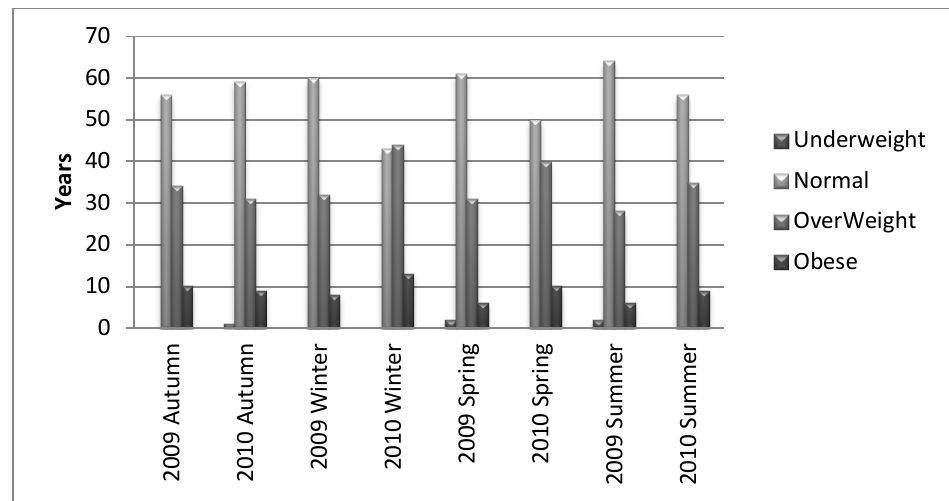
Figure 2. BMI changes of participants according to season and year.